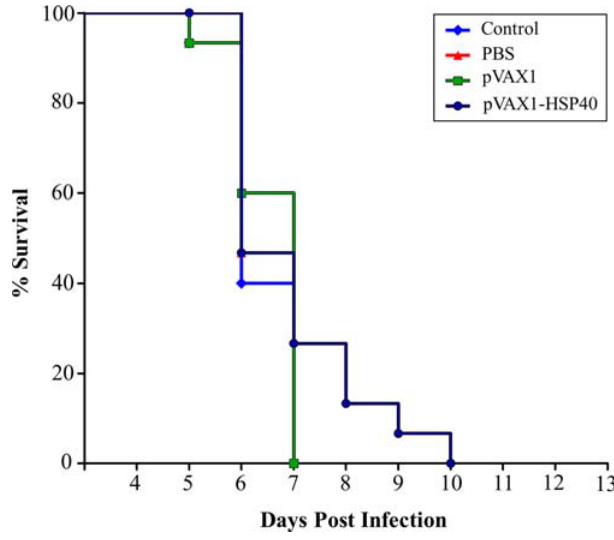
Figure 3. pVAX1-HSP40-based immunization failed to enhance the survival of acutely infected mice. Immunized and non- immunized mice were intraperitoneally challenged with 1 · 10 3 tachyzoites of T. gondii RH strain at two weeks post the final immunization and their survival times were recorded daily until all mice died. No statistically significant difference was observed between control mouse groups ( p > 0.05).